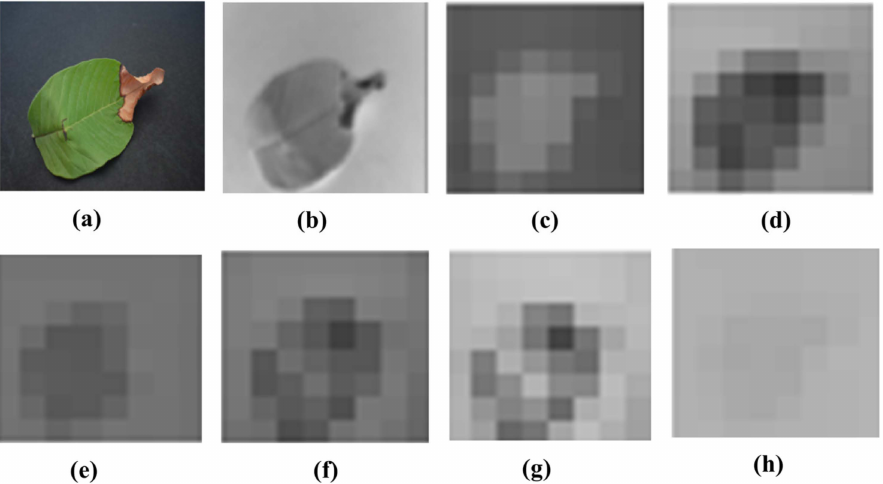
Figure 4. Visualization of the images of strong feature maps of different convolution layers. ( a ) conv_1 ( b ) conv_ 2 ( c ) conv_ 3 ( d ) conv_4 ( e ) conv_5 ( f ) conv_6 ( g ) conv_7 ( h ) conv2.